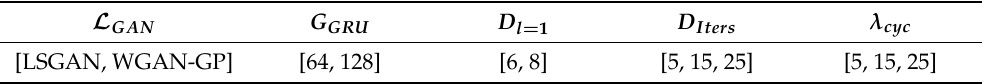
Table 1. Grid search of hyperparameters. refers to the adversarial loss function. G GRU and L GAN D l = 1 refer to the feature size of the generator’s GRU units and the first layer output’s discriminators. D Iters refers to the number of discriminators per generator updates (only for WGAN-GP; for LSGAN it is always